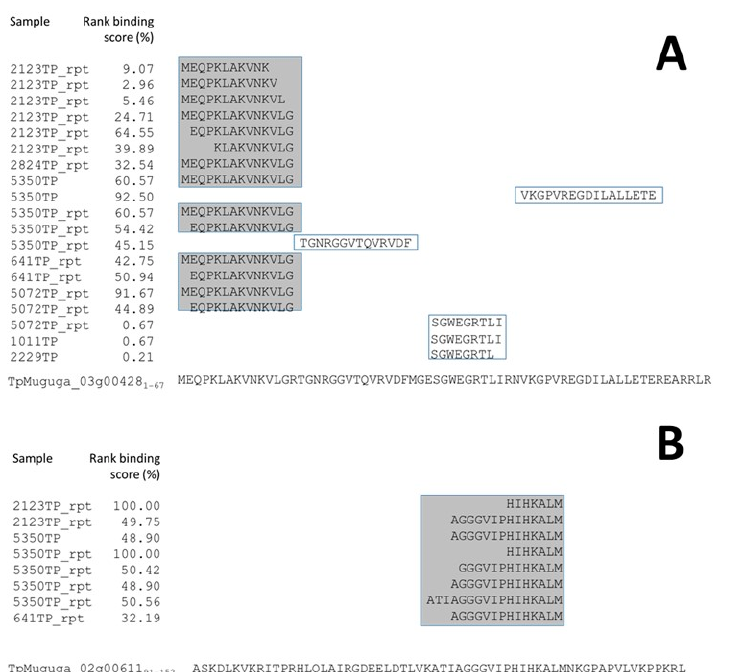
Figure 3. Alignment of peptides identified from ( A ) TpMuguga_03g00428 (ribosomal protein S28-B40S) and ( B ) TpMuguga_02g00611 (histone H2A variant 1) in BoLA-I elution datasets. ( A ) The 19 peptides identified from 8 different samples are shown aligned against the parent protein. Fourteen of the peptides (from 6 different samples representing 4 different MHCI haplotypes) are found as overlapping peptides in the 1–14 region. The median rank-predicted binding score of these peptides is 43.8% (range = 2.96–64.55%), with none predicted to be BoLA-I binders. The mean length of the peptides was 13 a.a. ( B ) The 8 peptides identified from 4 different samples (representing 3 different MHCI haplotypes) are shown aligned against the parent protein. All 8 peptides are overlapping peptides in the 121–137 region. The median rank-predicted score of these peptides is 50.1% (range = 32.2–100%), with none predicted to be BoLA-I binders. None of the peptides were of the 8–12 a.a. length of canonical MHCI-binding peptides.